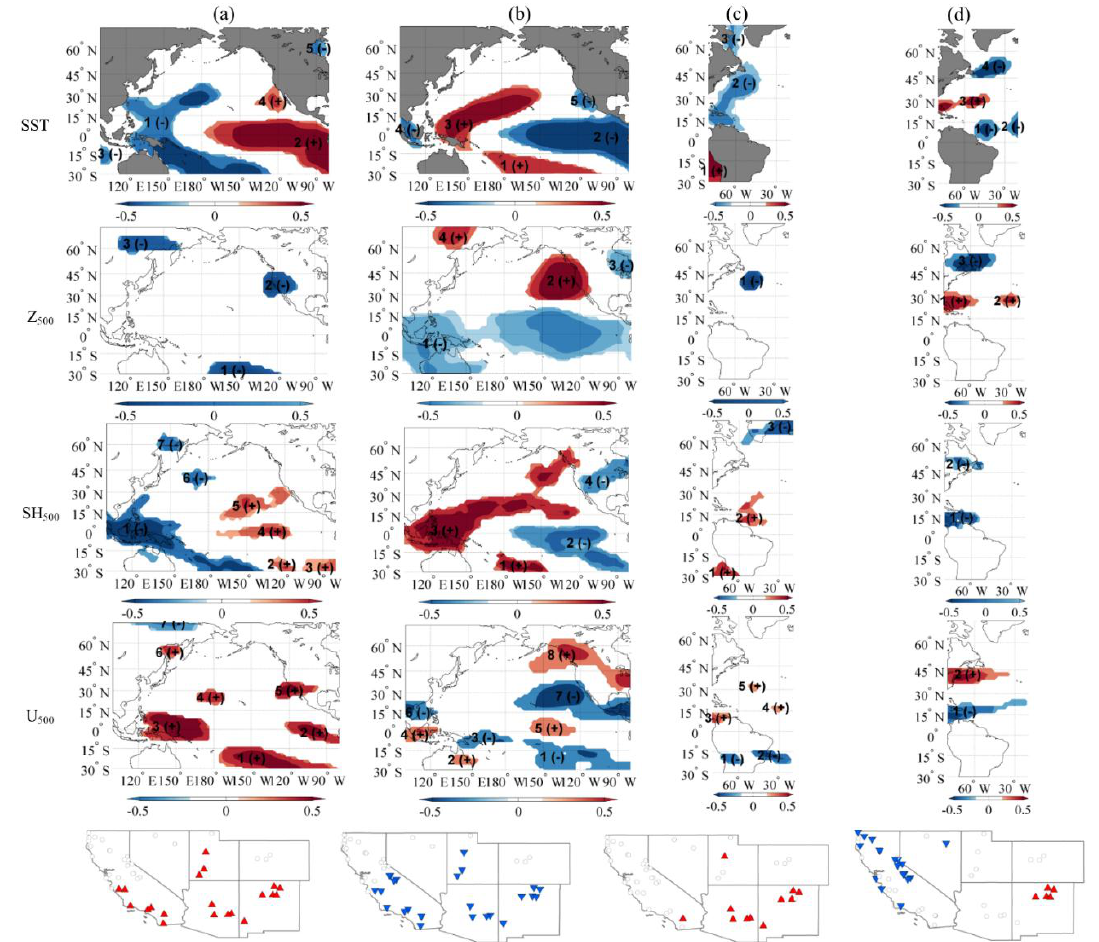
Figure 7. Heterogeneous correlation map developed for ( a ) Pacific September–November, ( b ) Pacific December–February, ( c ) Atlantic September–November, ( d ) Atlantic December–February SST, Z 500 , SH 500 , and U 500 with Southwest April–August streamflow. Significant regions with positive (negative) correlations are represented by red (blue). Significant streamflow stations are represented by red upward (blue downward) triangles.